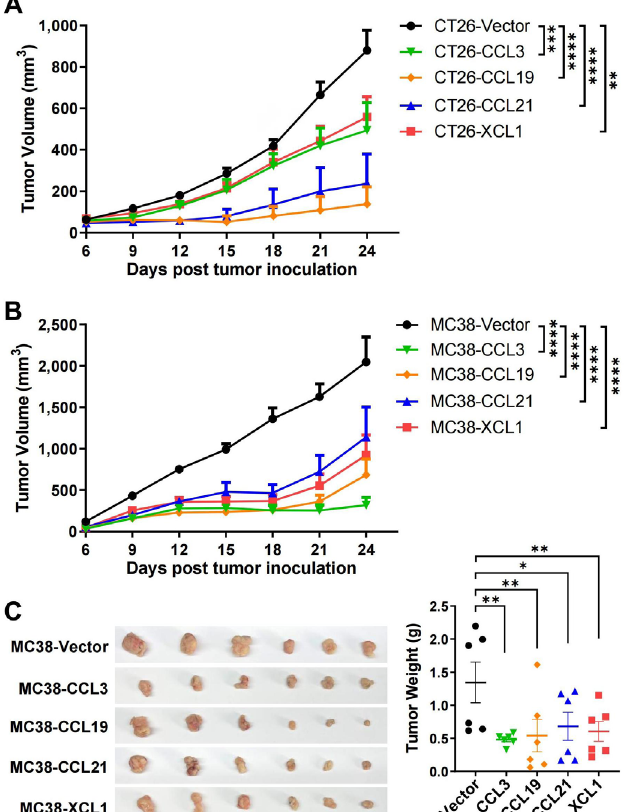
Figure 3. Tumoral overexpression of chemokines inhibits colorectal tumor growth. Volumes of CT26 tumors ( n = 5/group, A) or MC38 tumors ( n = 8/group, B) overexpressing chemokines or vector were monitored overtime; C. images and weights of MC38 tumors, scale bar = 1 cm.